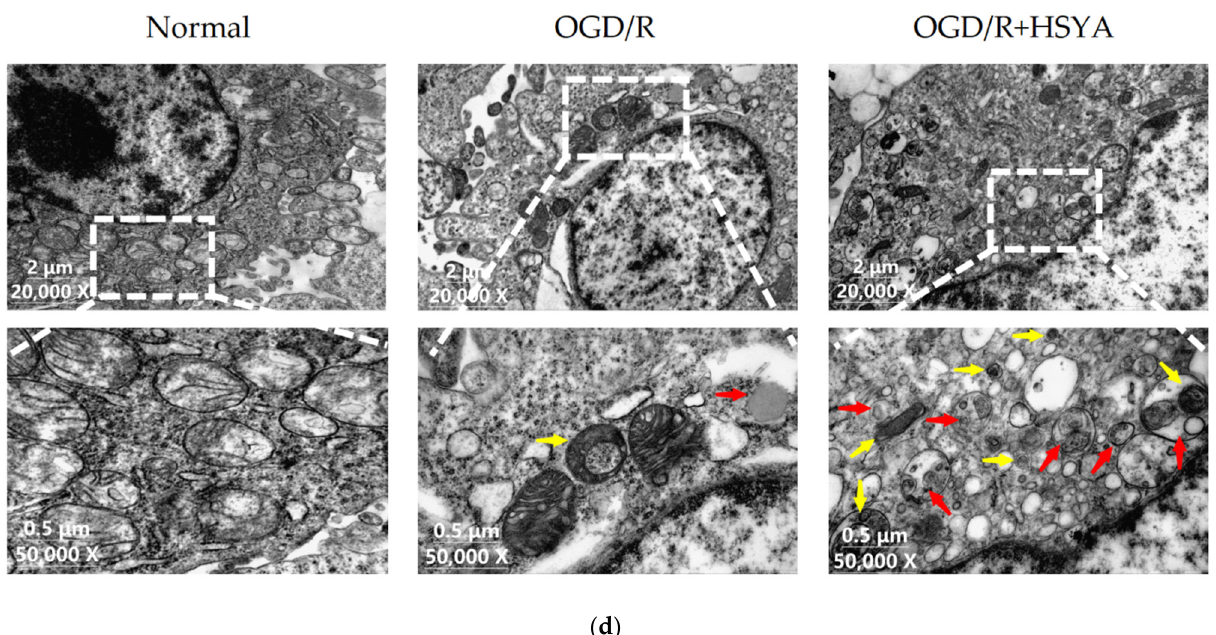
Figure 4. Screening the therapeutic target network of HSYA and selecting pivotal genes for validation. ( a ) Therapeutic targets of HSYA extracted using TCMSP. ( b ) Potential target genes for HSYA treatment of IS. ( c ) Western blotting was performed to detect the expression of HIF-1 α and Cleaved-Caspase-3. GAPDH was used as an internal control. ( d ) Images of OGD/R-damaged SH-SY5Y cells obtained from TEM. Yellow arrows indicate autophagosomes and red arrows indicate autolysosomes. The images in the lower panel are the enlarged areas of the rectangular boxes in the upper panel. The image is one of the representative results for each group. Results are representative of three independent experiments, and the data were statistically analyzed using one-way ANOVA and expressed as mean ± standard deviation. (Note: compared with the normal group, ### p < 0.001, ## p < 0.01; compared with the OGD/R group, ** p < 0.01.)